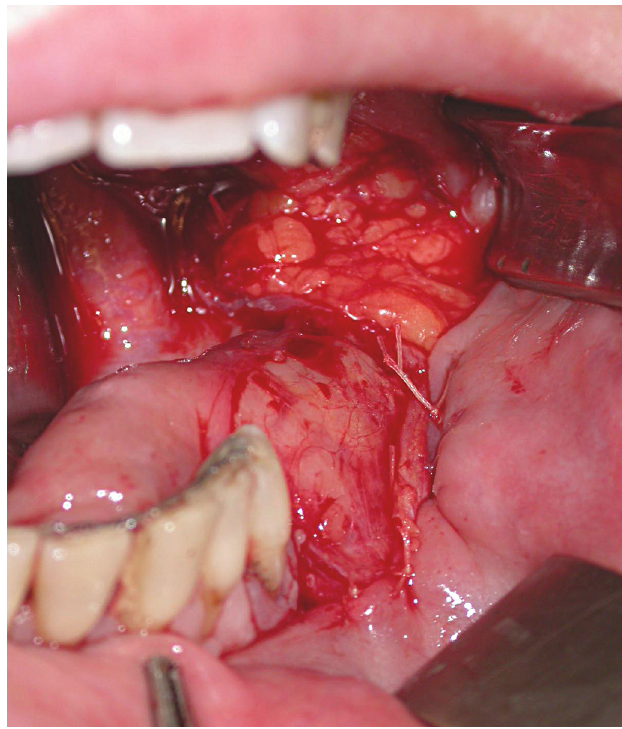
Fig. 2. Perioperative view of a sublingual gland fl ap associated with a buccal fat pad fl ap for reconstruction of a defect of the lateral fl oor of the mouth.